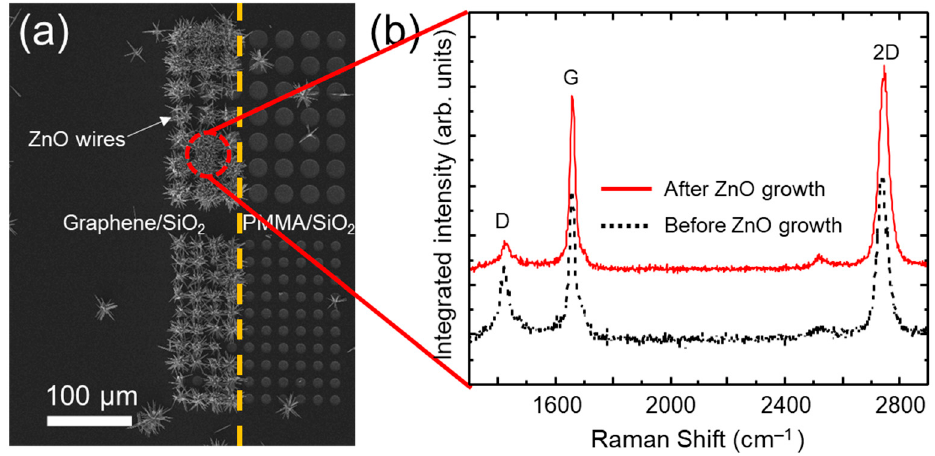
Figure 4. Top-view SEM ( a ) image of hydrothermally grown ZnO NWs on a hole patterned monolayer graphene/SiO 2 /Si substrate. The left and the right sides of the orange dashed line are the regions on monolayer graphene/SiO 2 /Si and SiO 2 /Si. ( b ) The room temperature Raman spectra of the monolayer graphene, obtained at the ‘red’ circle in ( a ), before (black, dashed) and after (red, solid) growth of ZnO NWs.